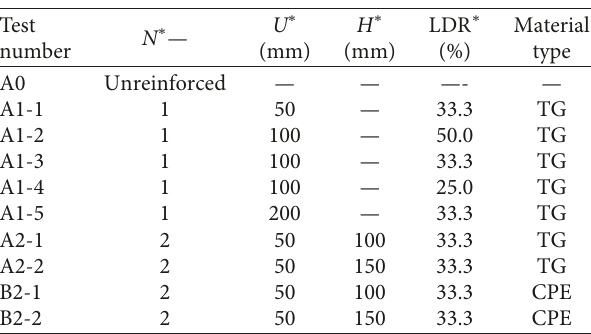
Figure 2: Top view of the testing setup.